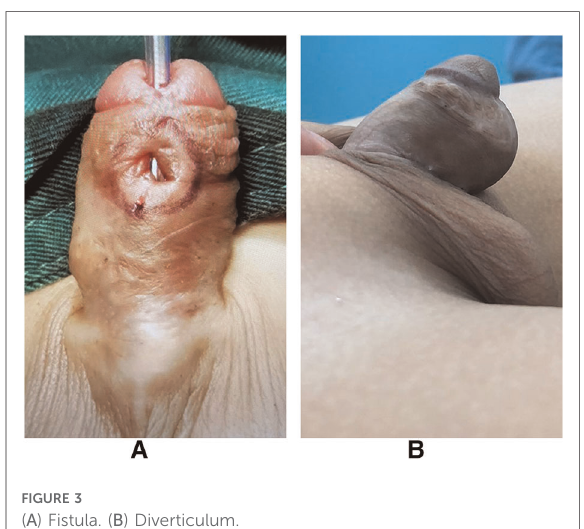
FIGURE 3 ( A ) Fistula. ( B )